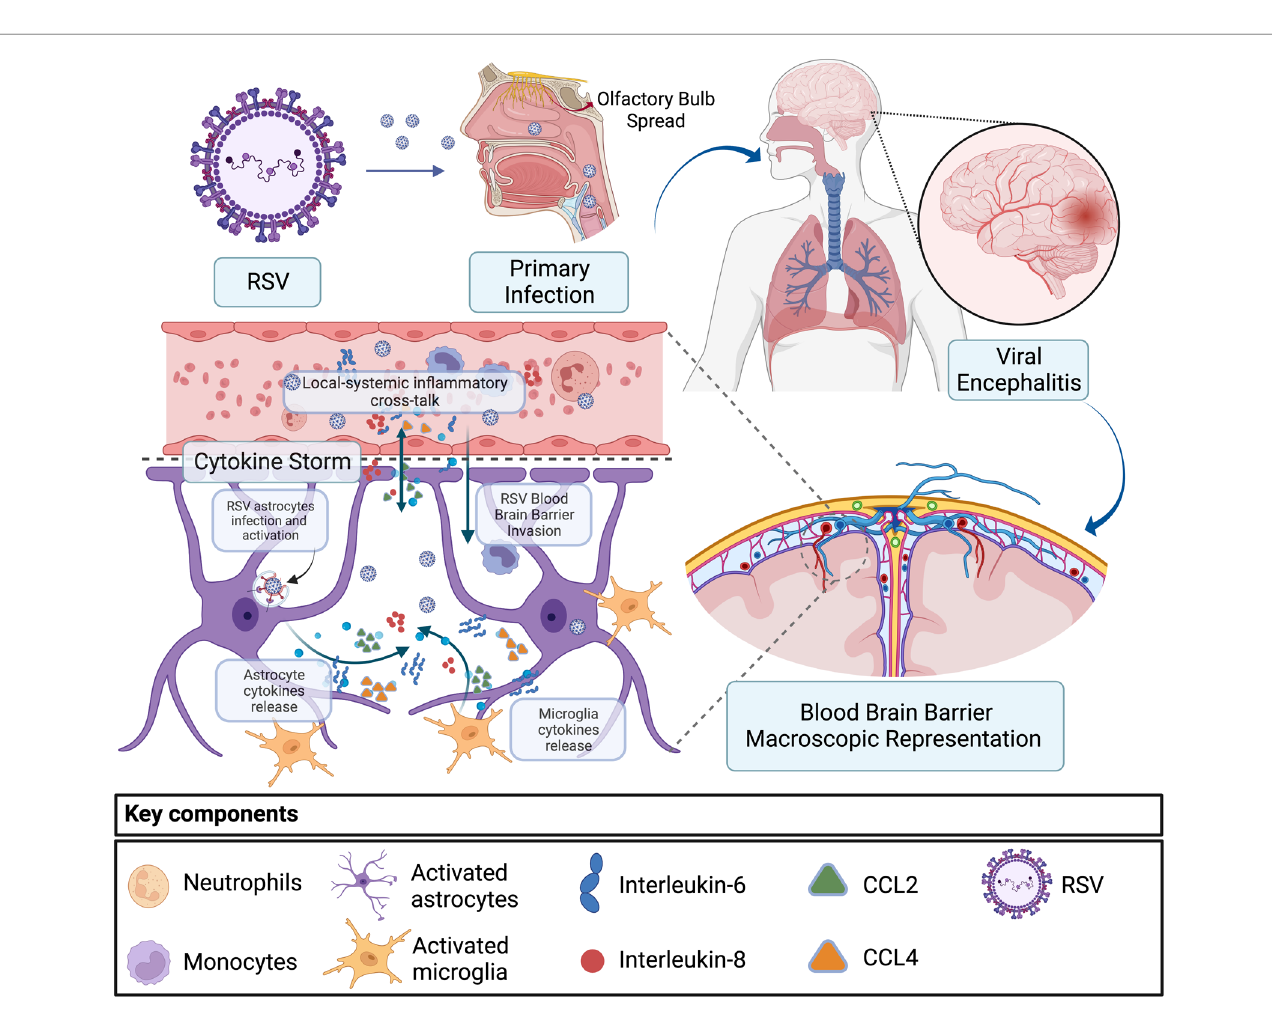
FIGURE 3 Encephalitis and cytokine storm secondary to RSV infection. RSV primary infection and spread from the respiratory tract to the CNS through the olfactory bulb or via the hematologic route. In the second scenario, RSV migrates through the blood – brain barrier infecting astrocytes and microglia, inducing upregulation of IL-6, IL-8, CCL2, and CCL4, which results in an eventual local-systemic in fl ammatory cross-talk that contributes to encephalitis and systemic in fl ammation. RSV, respiratory syncytial virus; CNS, central nervous